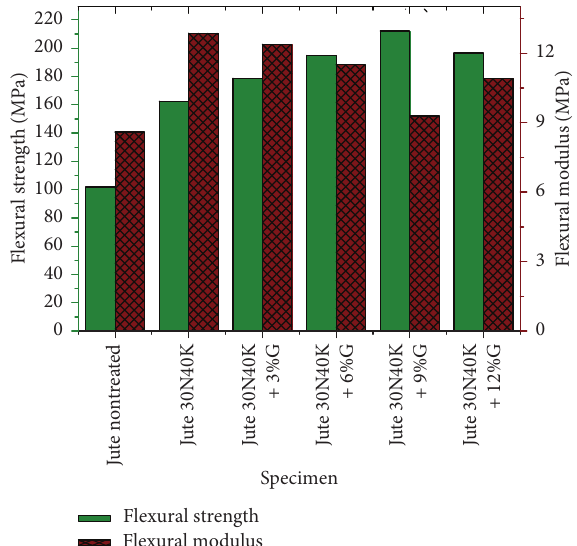
Figure 6: Flexural strength of UJE polymer composites.